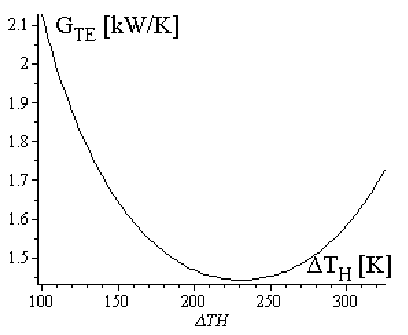
Figure 14. G TE dependence of Δ T H —case “a”. G TEmin = 1.443 kW/K for Δ T H = 231 K.